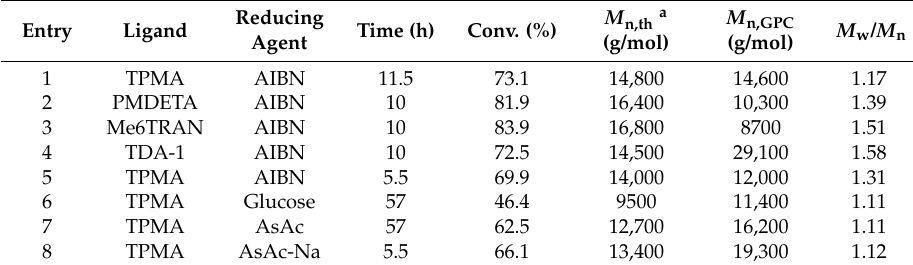
Table 2. Effect of kinds of ligand and reducing agent on